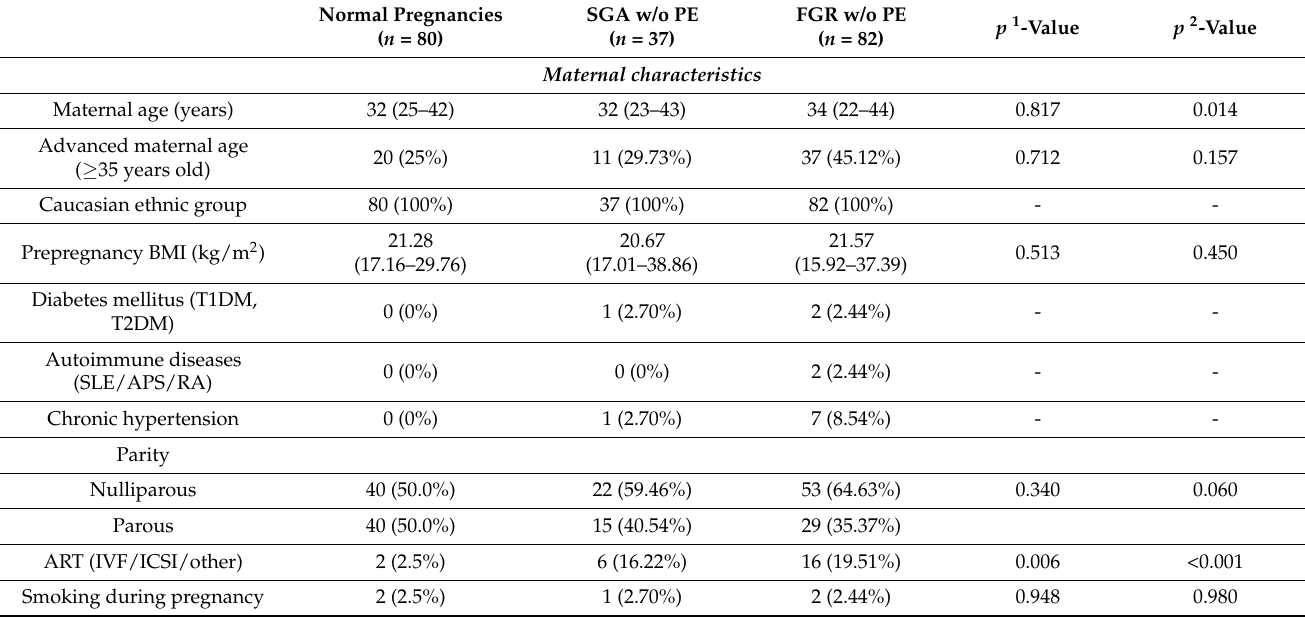
Table 1. Clinical characteristics of the controls and complicated